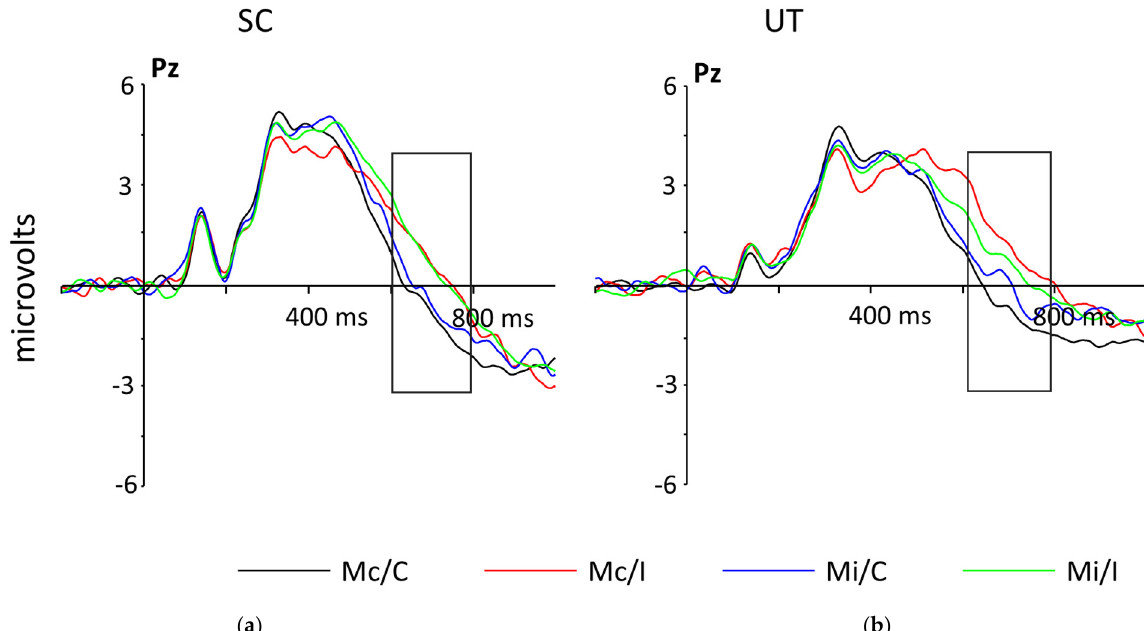
Figure 4. Grand-averaged stimulus-locked ERPs at electrodes Pz demonstrating the time course of the SP for ( a ) participants who played SC and ( b ) participants who played UT. I trials are significantly more positive than C trials, with the greatest amplitude in the Mc block. There were no significant differences between the two gaming groups.